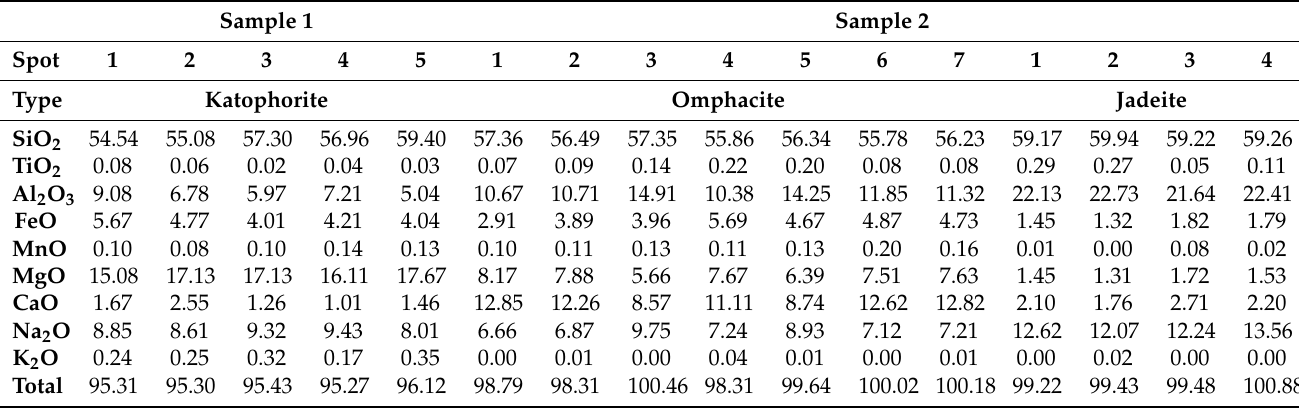
Table 1. Major element compositions of katophorite, omphacite and jadeite in Samples 1 and